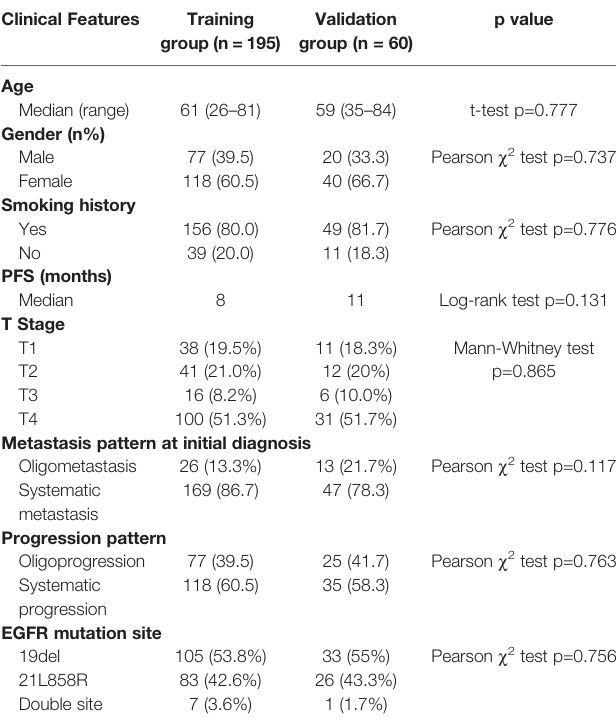
TABLE 2 | Comparison of clinical features in patients with progression patterns information.